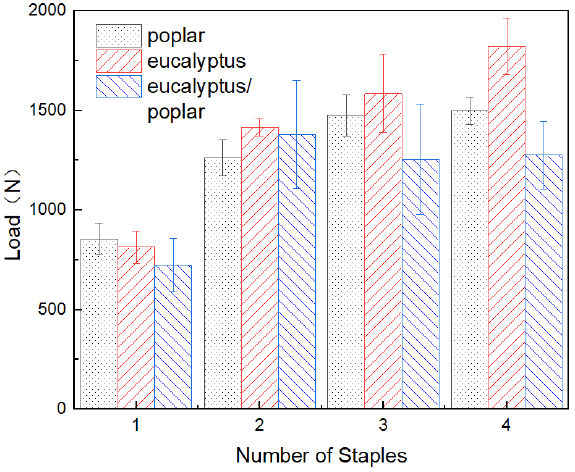
Figure 6. Withdrawal load histogram.